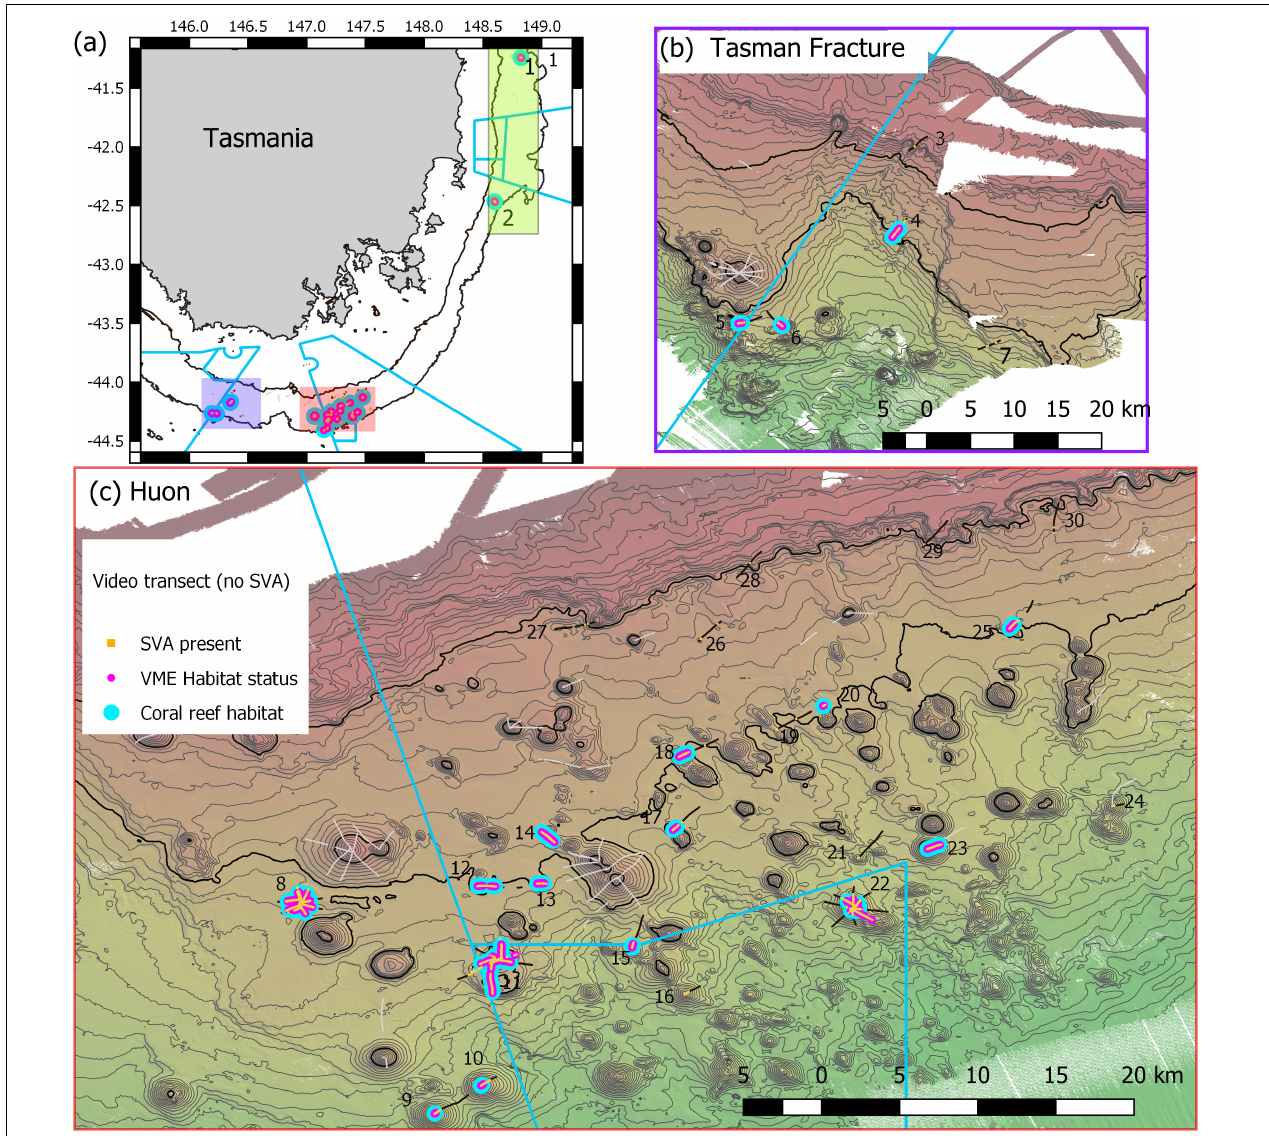
FIGURE 10 | Distribution of Solenosmilia variabilis coral reef VME habitat (blue) across all sites. Scenario uses criteria of 25% cover of coral reef and 1 live head, a moving window with a ratio of 3:5, and a live head threshold of 5.6). Depth contours: panel (a) 250 and 2000 m – define the limits of the survey area; panels (b,c) 50 m intervals with 950 and 1350 lines bolded.